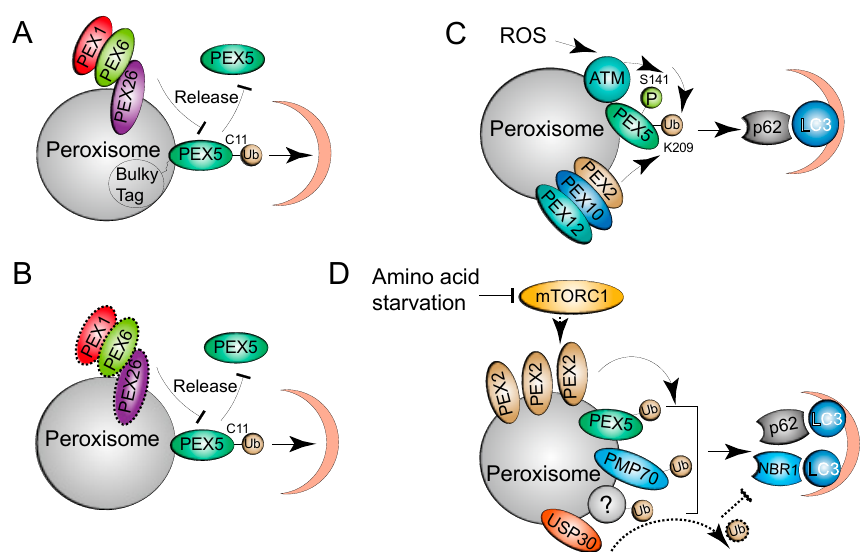
Figure 2. Mechanisms of ubiquitin-dependent pexophagy. ( A ) PEX5 fused to a C-terminal bulky tag can be monoubiquitinated at C11 but fails to be extracted back to the cytosol by the AAA complex. The accumulated monoubiquitination of the PEX5 fusion proteins serves as a signal to direct pexophagy. ( B ) Loss of AAA complex function (dashed border) results in the accumulation of monoubiquitinated PEX5 proteins in peroxisomes, which promotes pexophagy. ( C ) Activation of ATM by ROS phosphorylates PEX5 at S141, which facilitates PEX5 monoubiquitination at K209 by the PEX2, PEX10, and PEX12 complex (E3 ligase complex). The autophagy receptor p62 recognizes ubiquitinated PEX5 and recruits the core autophagy machinery to eliminate damaged peroxisomes in response to oxidative stresses. ( D ) Under conditions of amino acid starvation, PEX2 proteins are stabilized upon mTORC1 inhibition. Upregulation of PEX2 promotes the ubiquitination of peroxisomal proteins, including PEX5, PMP70, and other unknown proteins, which serve as signals for NBR1 and p62-mediated pexophagy. The deubiquitinase USP30 removes the ubiquitin from peroxisomal proteins and inhibits pexophagy during amino acid starvation.